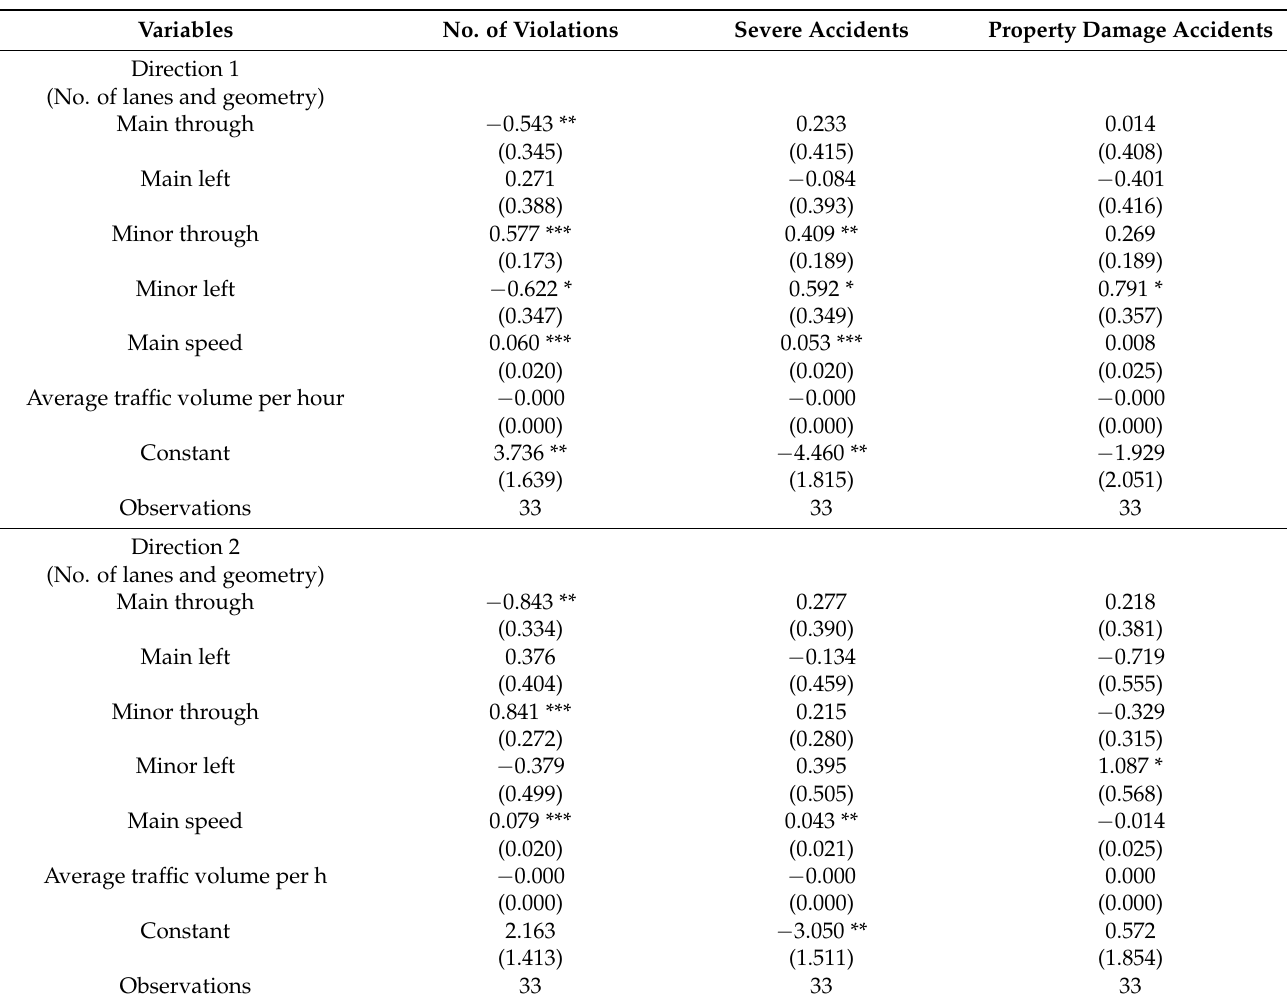
Table 2. Effect of geometric conditions on safety performance of four-leg